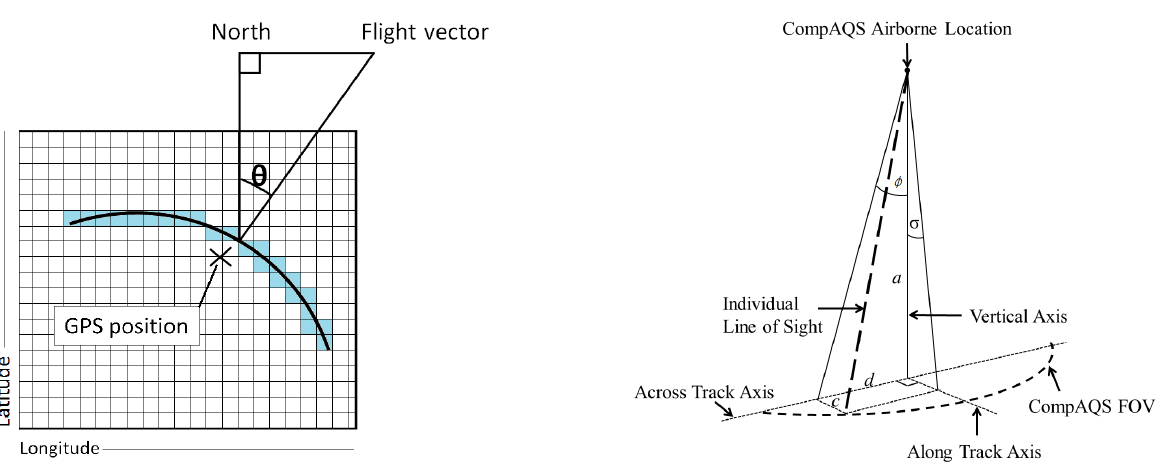
Figure 3. Schematic demonstrating the dimensions and geometry used to define the terms given in Eqs. (1) to